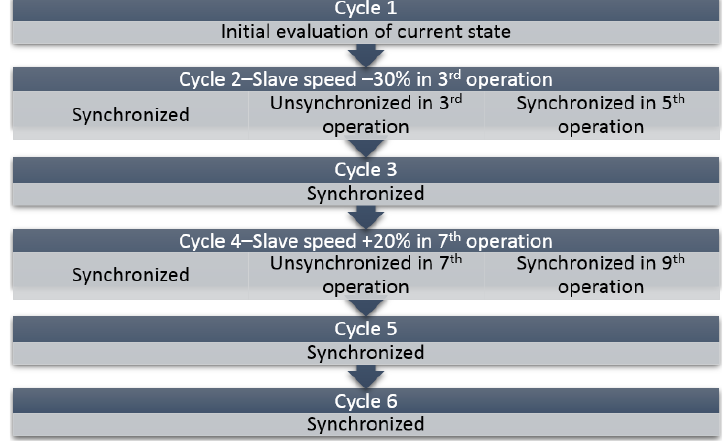
Figure 15. Brief summary of Experiment 2b results.